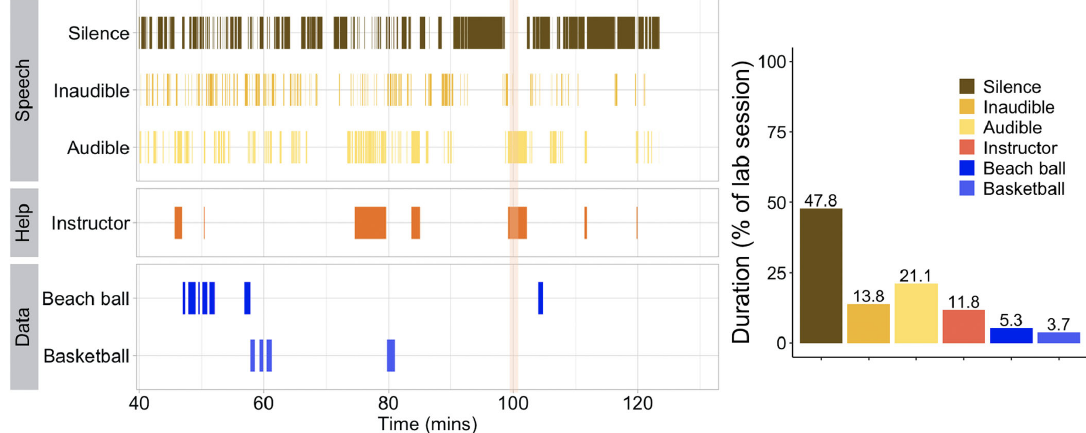
FIG. 14. Group E full timeline and durations of each behavior as a percentage of the video analyzed. Because of the extended silence and frequent inaudible speech, we were not able to identify on and off topic speech consistently. The portion analyzed in Sec. V B 1 is highlighted.